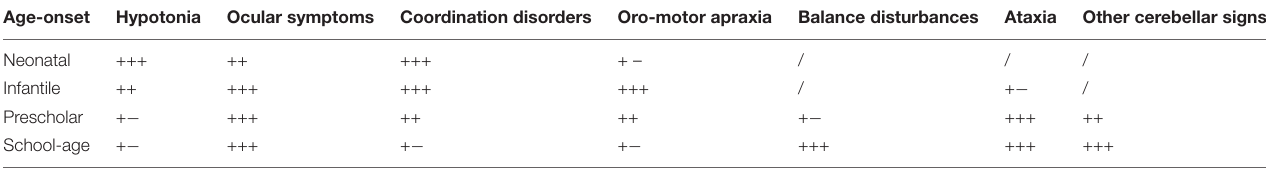
TABLE 1 | Age related signs and symptoms in cerebellar